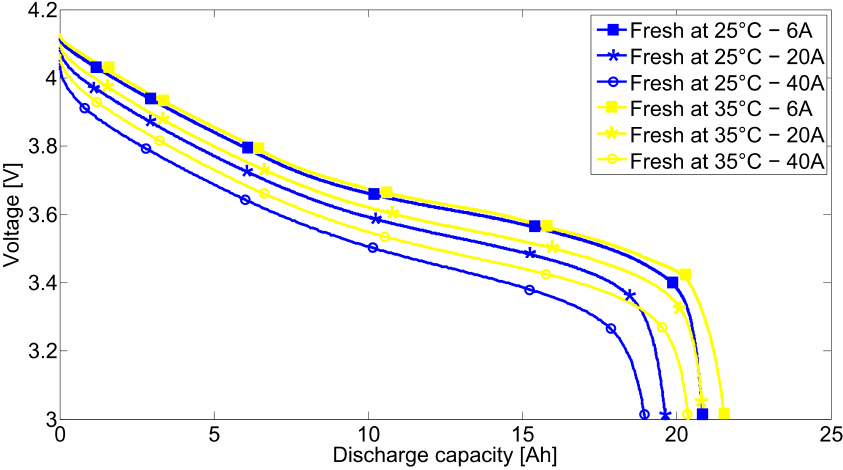
Figure 9. Discharge capacity at 25 ◦ C and 35 ◦ C of the cell 1 at different current